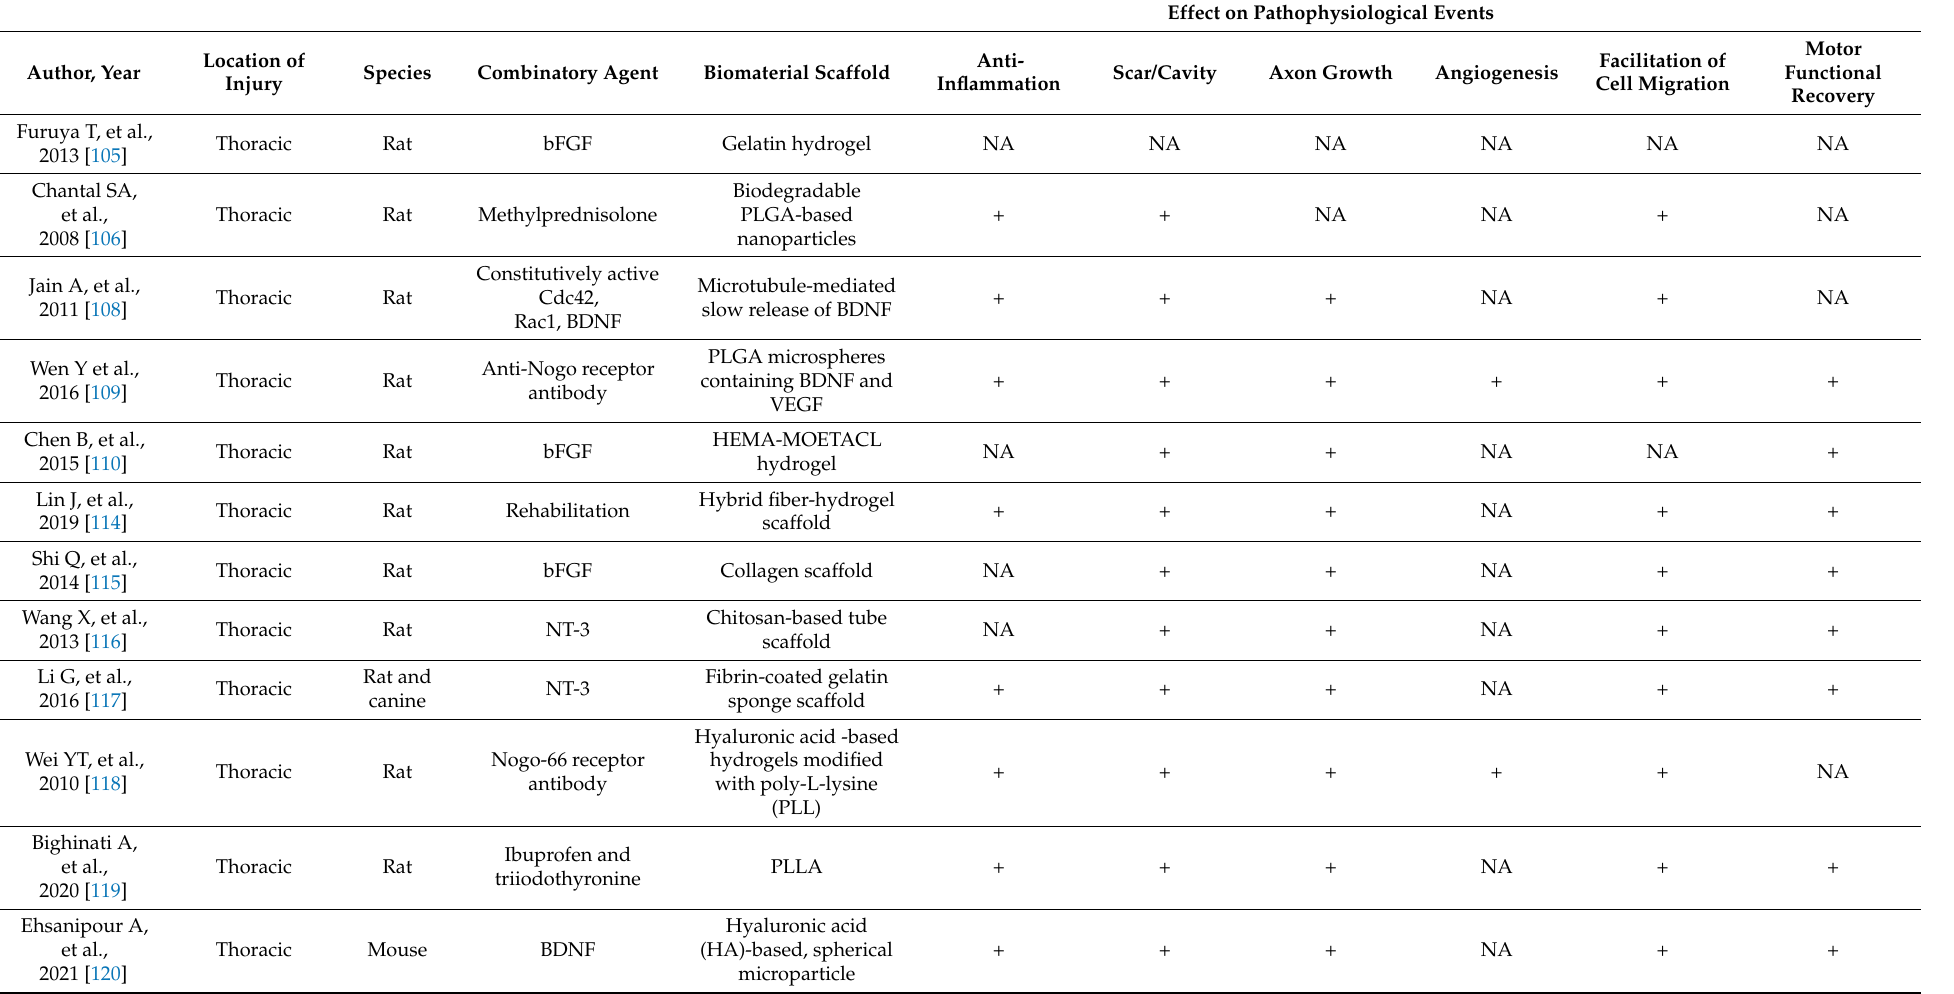
Table 4. Summary of the included studies and the effect of biomaterial scaffolds in combinatory treatment for